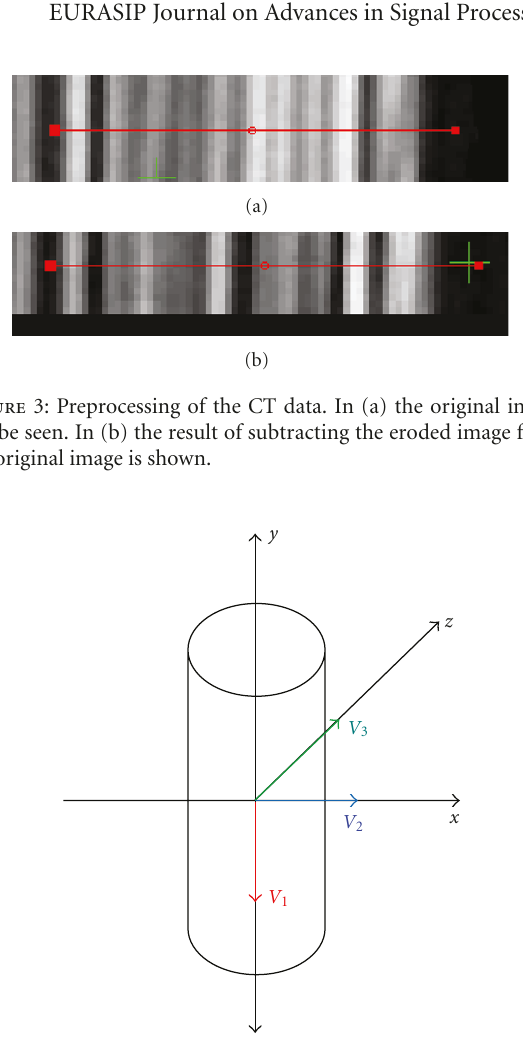
Figure 4: The model of the ideal fiber including the coordinate system around a center